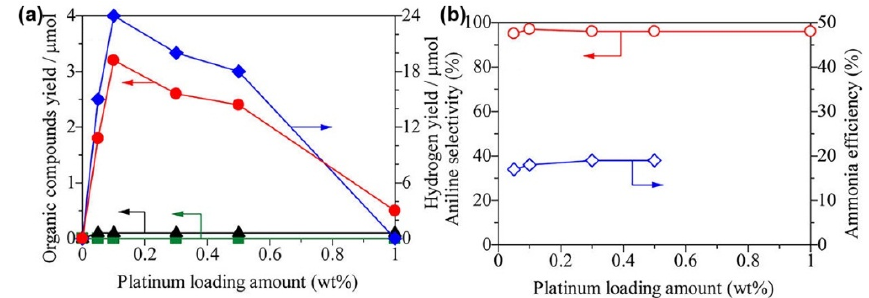
Figure 8. ( a ) Conversion yield of Pt/TiO 2 versus the Pt loading amount; ( b ) Aniline selectivity of Pt/TiO 2 versus the Pt loading amount. Reproduced from [107], with copyright permission from American Chemical Society, 2013.